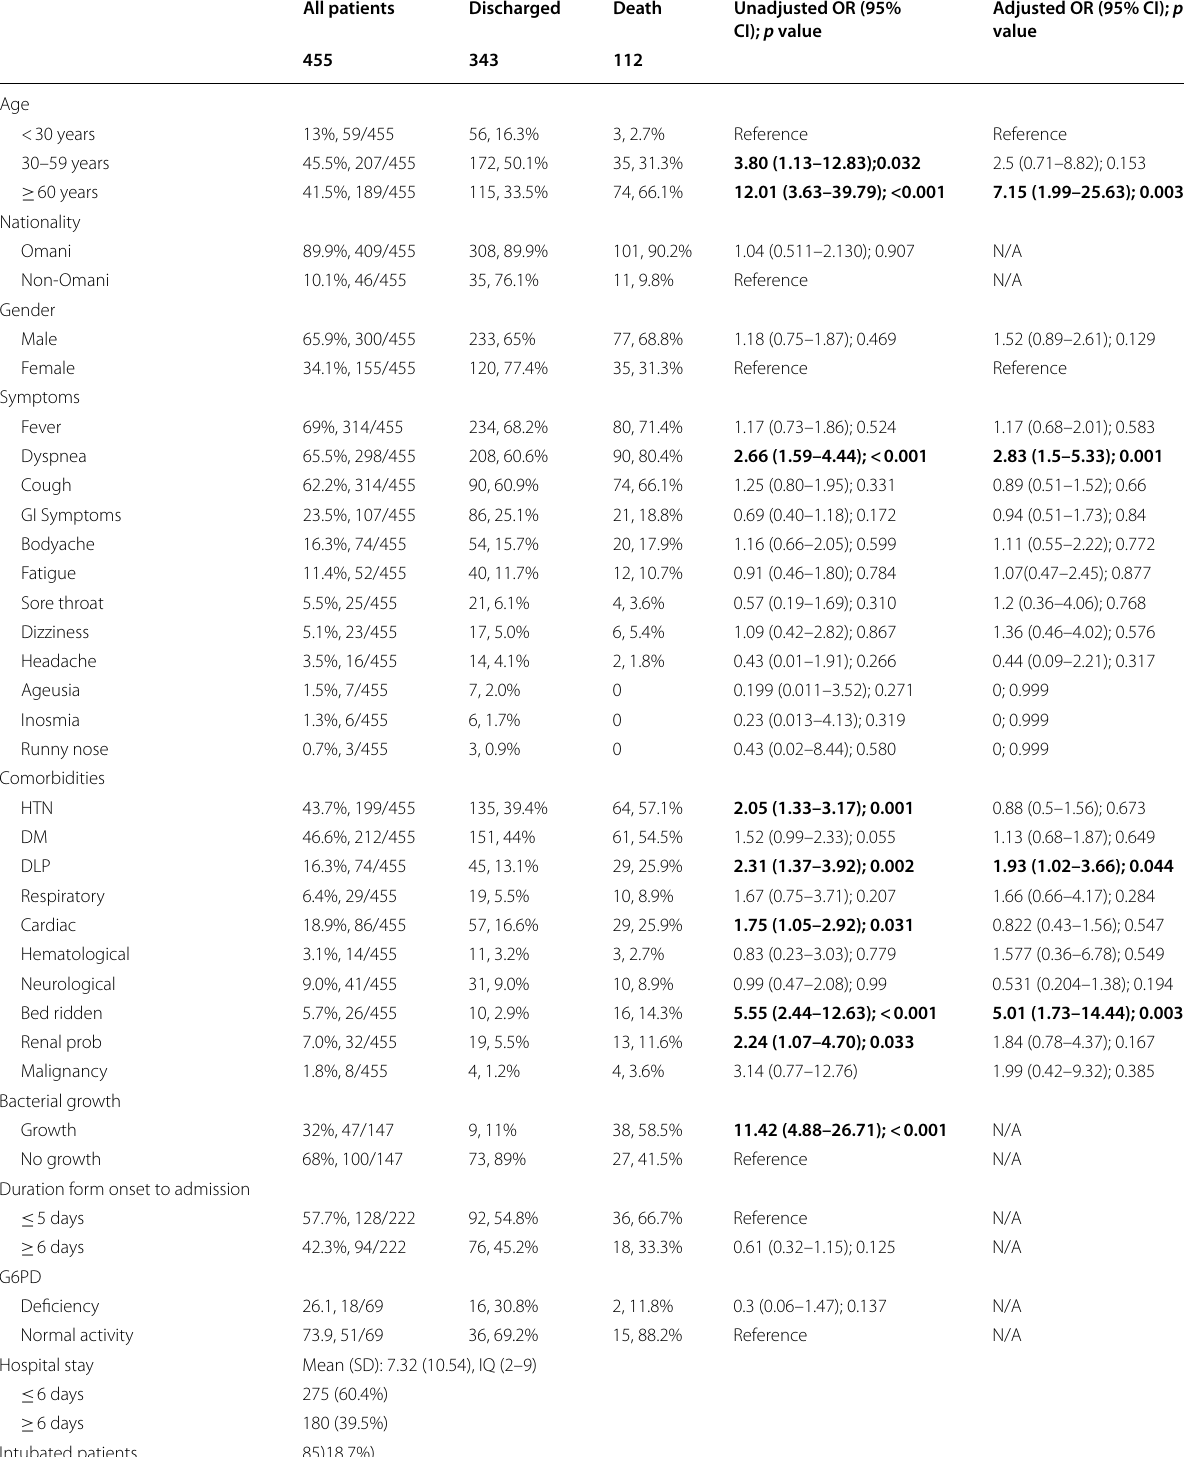
Table 1 Patient characteristics, unadjusted and adjusted odds ratios and 95% confidence intervals for the likelihood of